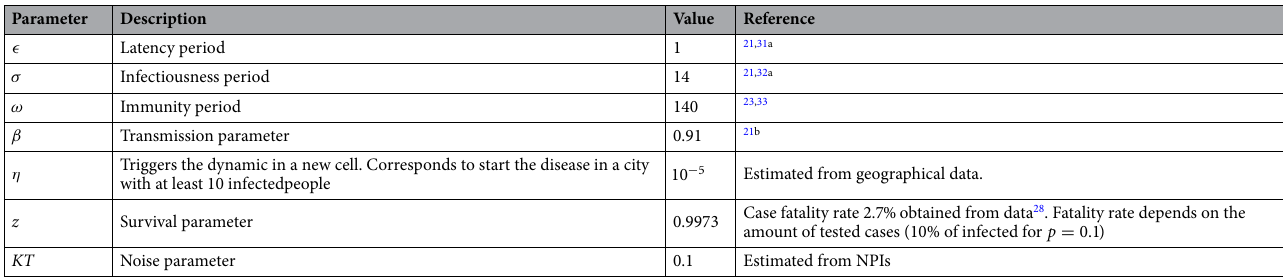
Table 1. Model parameters. a In the case of SARS-Cov-2, infectiousness starts before the onset of symptomatic period 31,32,34,35 . Therefore, in terms of the model, ǫ is shorter than the non-symptomatic period (1–6 days 31,36 ) and σ is larger so that compartment E includes noninfectious people, and compartment I includes all the infectious ones. Since presymptomatic infections occur up to 4 days 32 before symptoms onset, and most COVID-19 ill people can have replicable viruses 10 or more days after that 33 , we estimate ǫ and σ as showed above. b β was obtained by fitting the model with the mentioned ǫ and σ values in Ref. 21 .